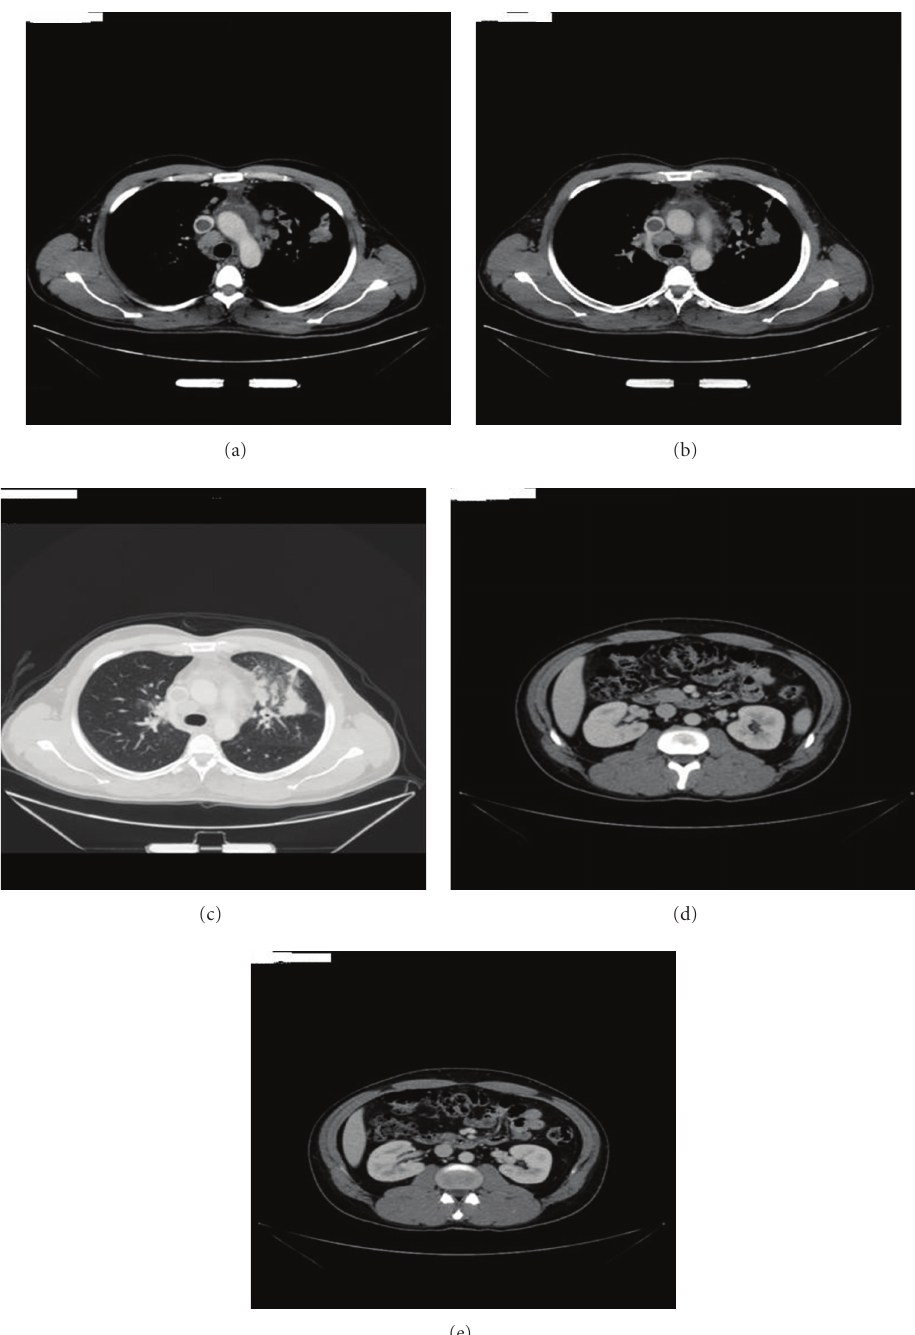
Figure 1: (a, b, and c) CT- chest showed left upper lobe mass mediastinal lymph nodes enlargement and superior vena cava thrombosis.(d and e) CT- abdomen showed spleen, pancreas, both adrenals, and both kidneys are normal. No ascites was